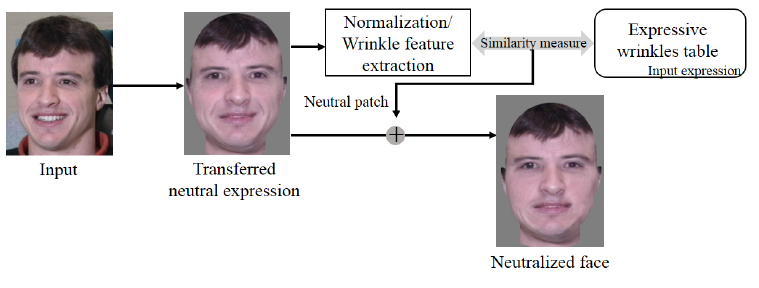
Figure 13. Expression neutralization process.